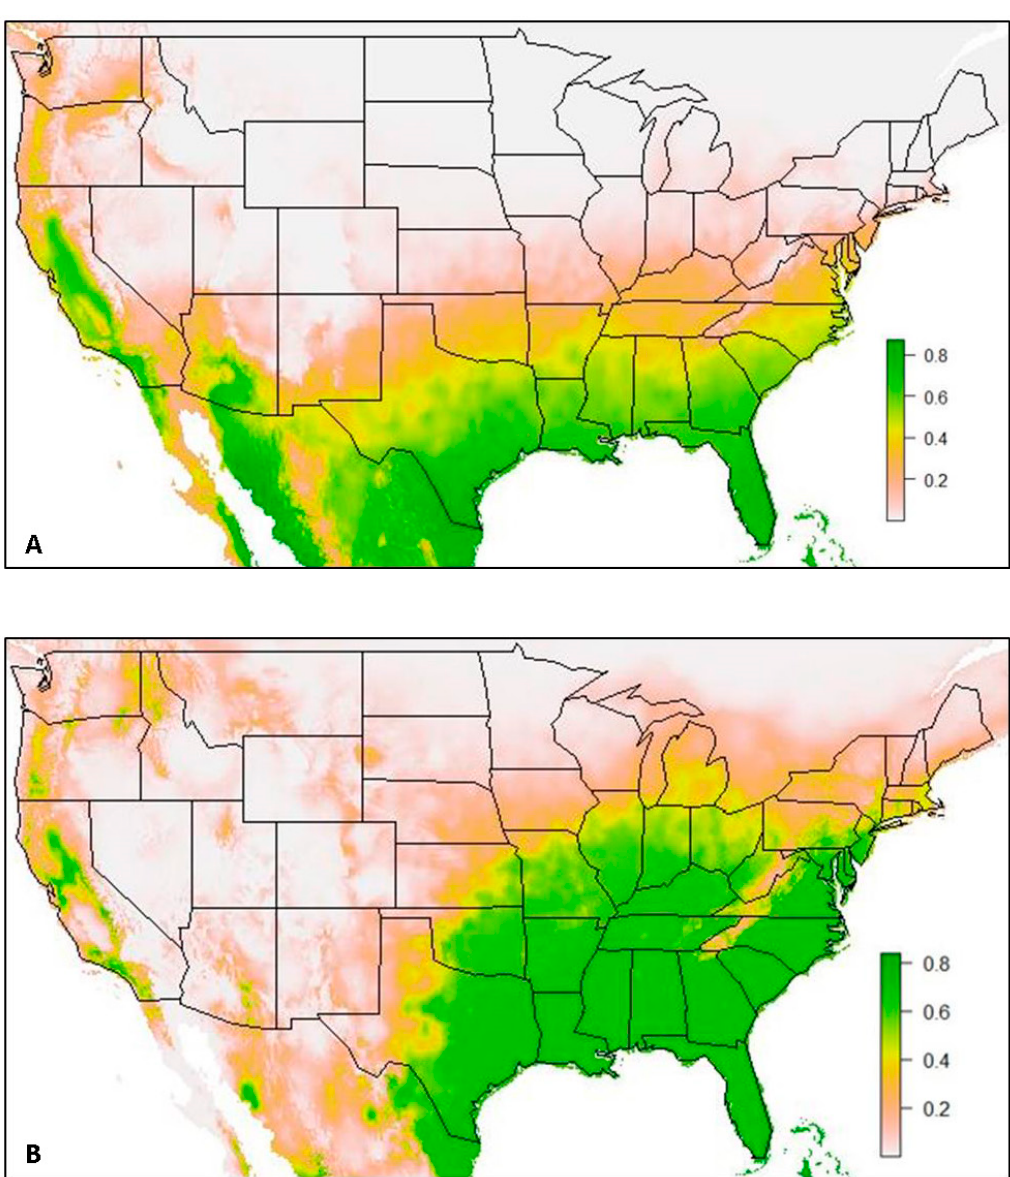
Figure 4. ( A ) Model 2a: Species distribution model of Ae. aegypti , and ( B ) Model 2b: Species distribution model of Ae. albopictus , both using all occurrence records from 1960–2014 (Kraemer et al. 2015b database) and excluding the 2016 and 2017 VZL data from model input. Green coloration indicates areas of high predicted habitat suitability (suitability ≥ 0.6), with darker green indicating areas with highest habitat suitability (suitability ≥ 0.8), yellow coloration indicates moderate habitat suitability (suitability = 0.4–0.6), tan coloration indicates low habitat suitability (suitability = 0.2–0.4) and white to light tan coloration indicates extremely low habitat suitability (suitability = 0.0–0.2).